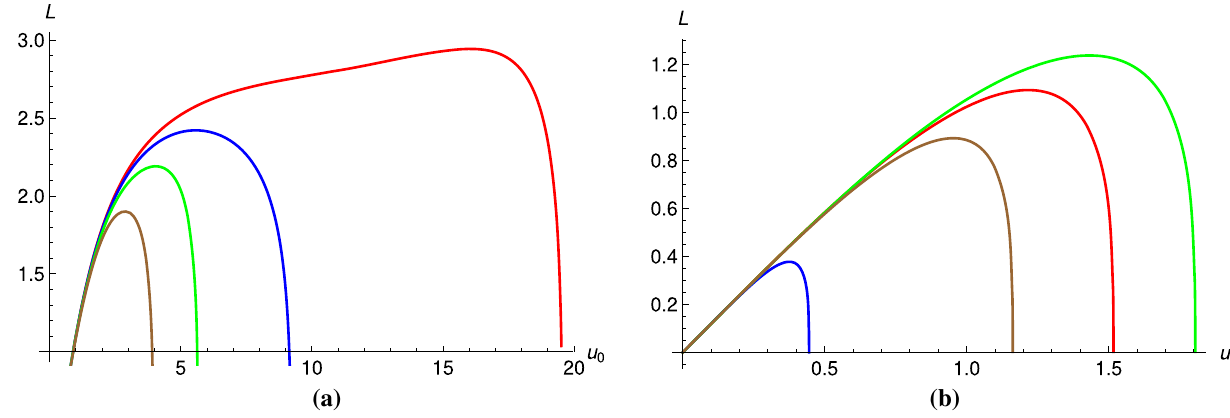
Fig. 9 Q ¯ Q -distance vs. u 0 : ¯ a = . 1 , ¯ α = . 001, T = T 1 (red), T = T 2 (blue); ¯ a = . 2 ,α = . 004, T = T 1 (green), T = T 2 (brown); black holes with radius a small, b